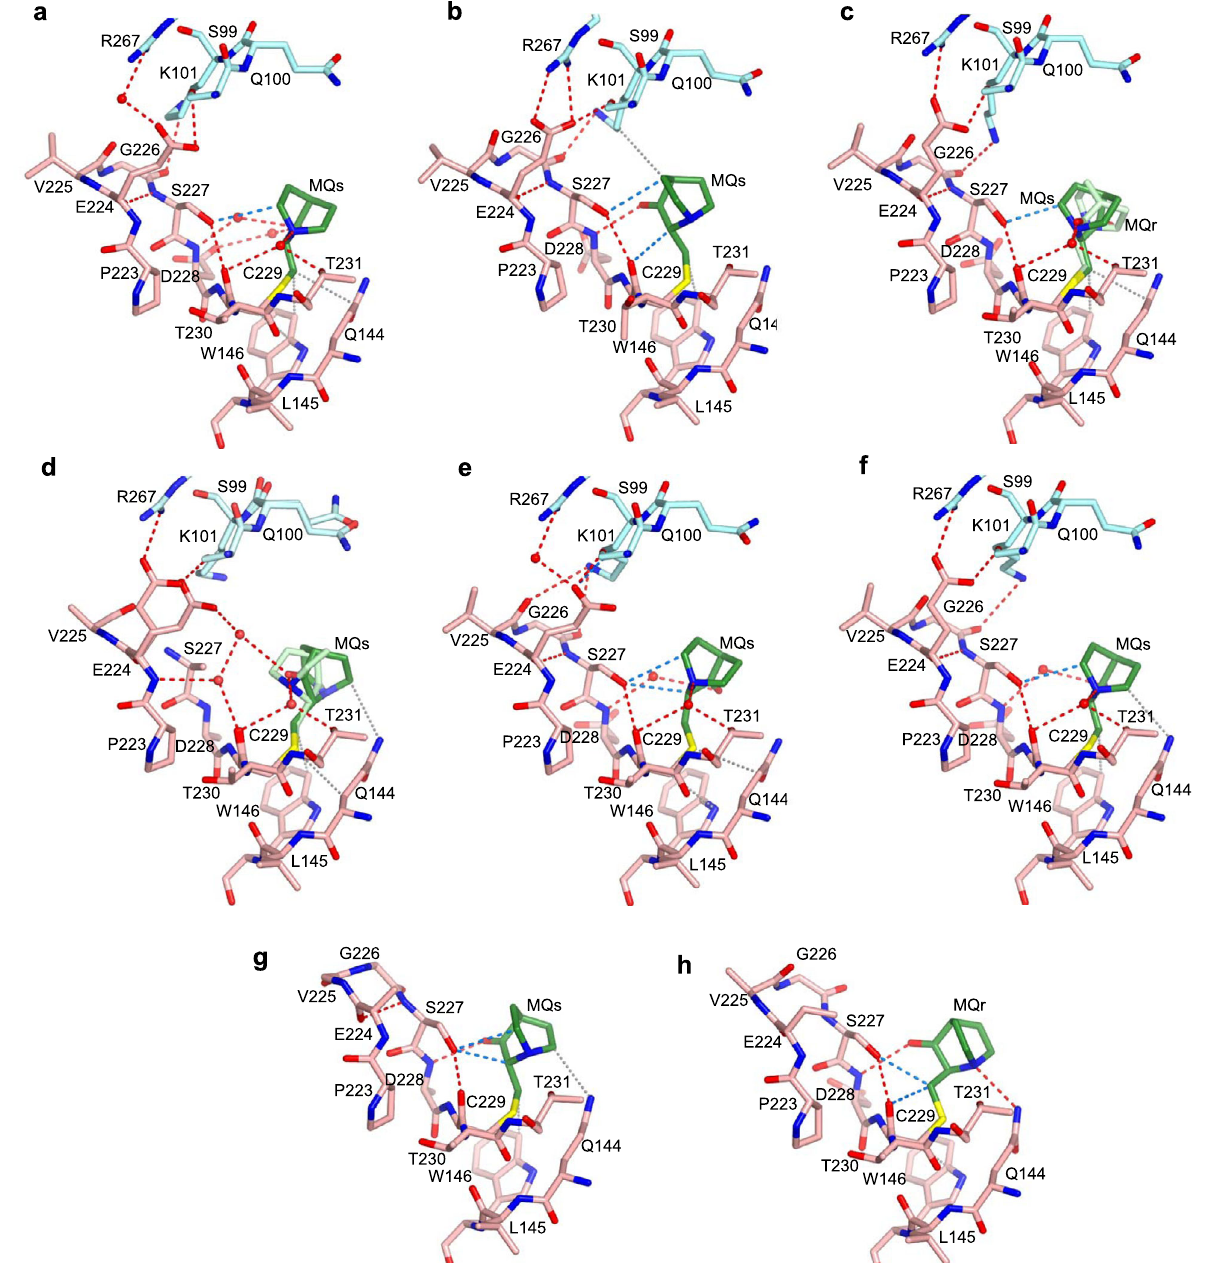
Fig. 8 MQ bound to C229 in p53-DNA complexes. The MQ-C229 conjugates and the stabilizing interactions are based on the following structures. a R273H-DNA-MQ. b R282W-DNA-MQ. c R273C/S240R-DNA-MQ. d wt-DNA-MQ (I). e wt-DNA-MQ (II). f wt-DNA-MQ (III). g wt-DNA-MQ